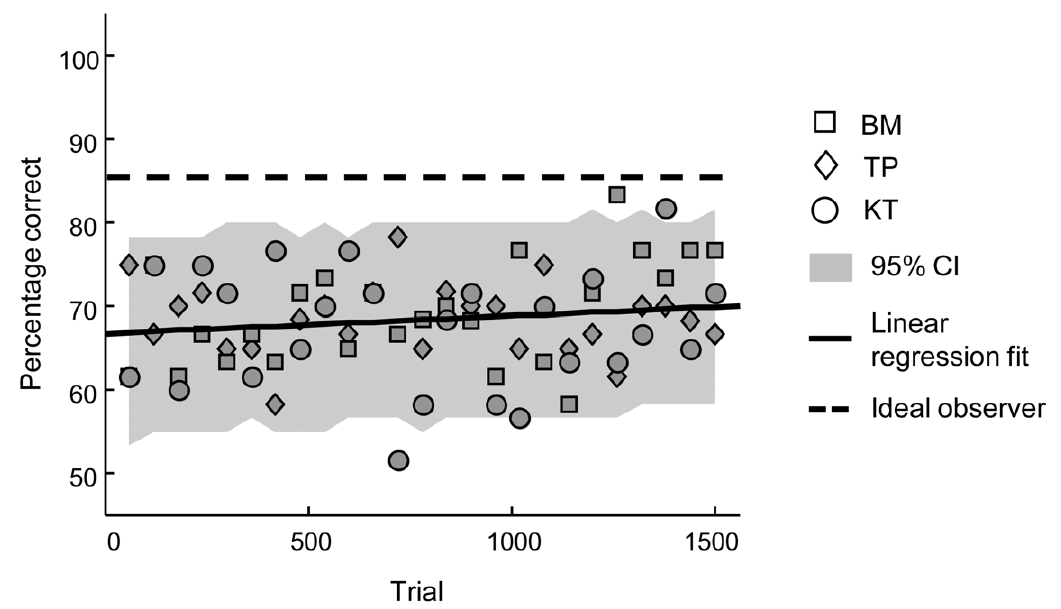
Figure 7. Results of the control experiment. Symbols indicate the pooled data of individual observers. The full line indicates the linear regression fit. The broken line denotes the performance of the ideal observer.